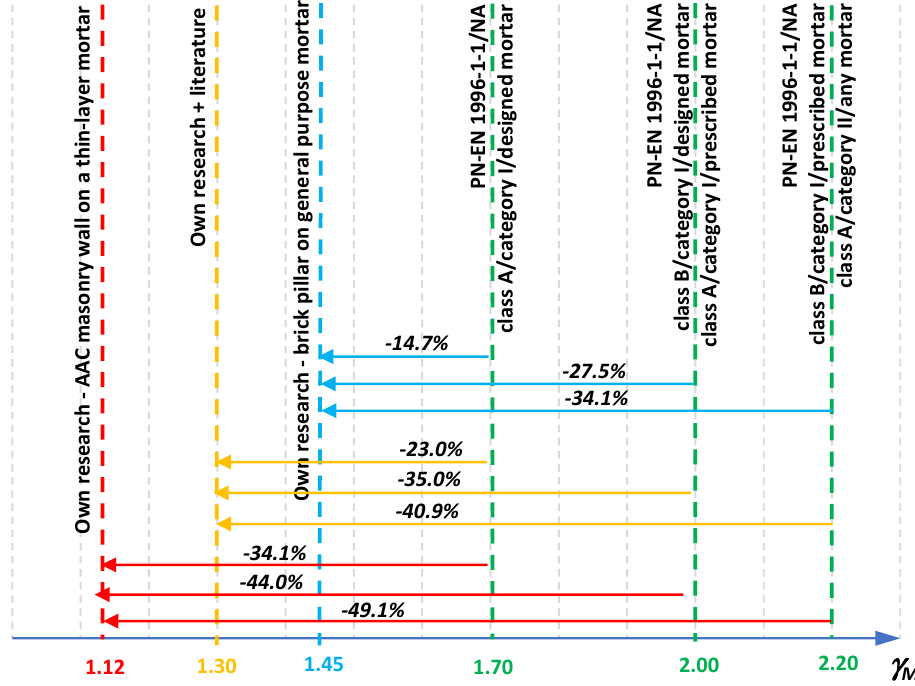
Figure 20. Comparison of the calculated values of the partial safety factor for masonry structures designed in the RC2 reliability class with the values recommended in the National Polish Annex of the standard [PN-EN 1996-1-1: 2010].